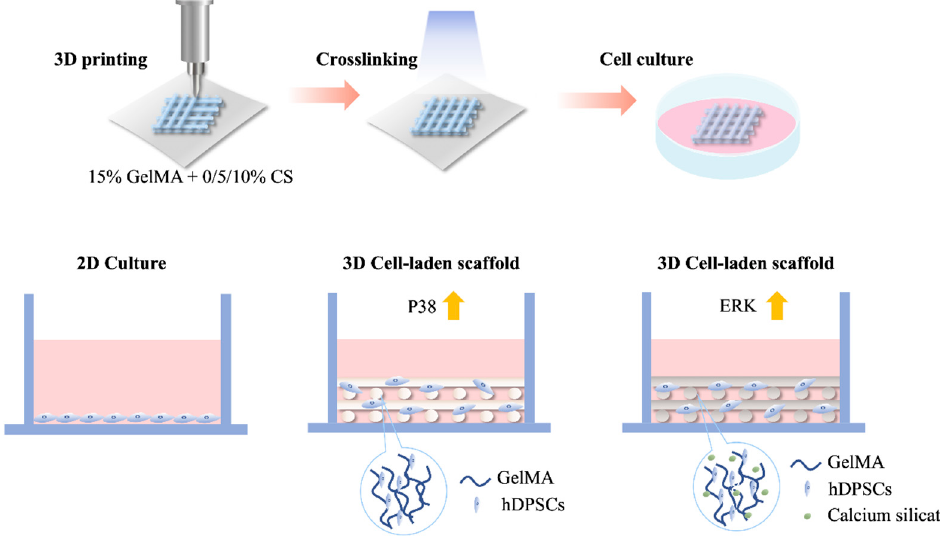
Figure 1. Schematic diagram depicting the fabrication of CS/GelMa scaffolds and advantages of hDPSCs-laden CS/GelMa scaffolds for odontogenesis.